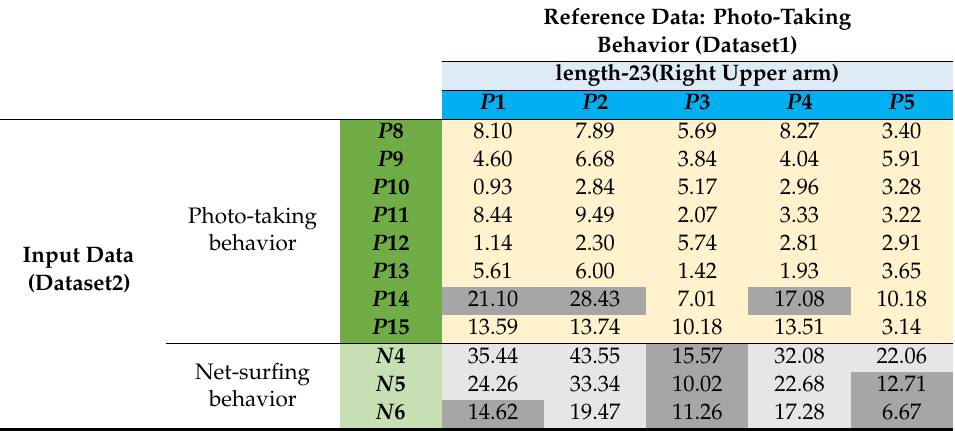
Table 4. DP matching result of dataset2 when using dataset1 as the reference data (Reference data: